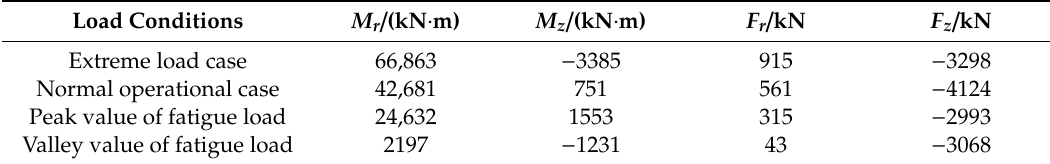
Table 2. Forces at the tower base under different load cases.